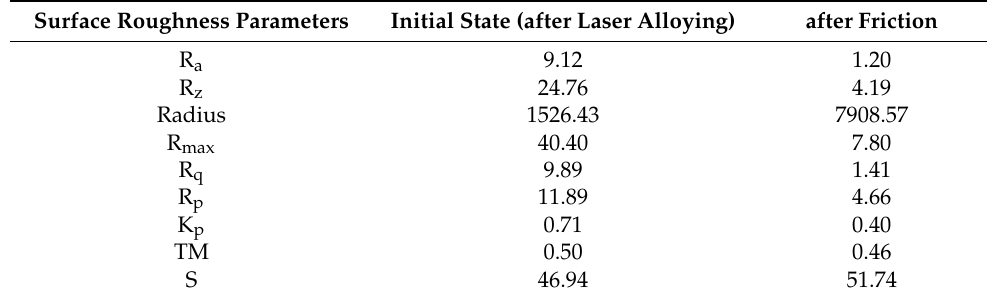
Figure 14. ( a ) Profilograms and ( b ) reference curves for surface layers of AISI 304 steel after laser alloying with a plaster of 85Nb + 15% liquid glass (curve 1) and after friction (curve 2). Table 4. Parameters of profilograms ( µ m) of the friction surface of AISI 304 steel after laser alloying with a plaster of 85Nb + 15% liquid glass.